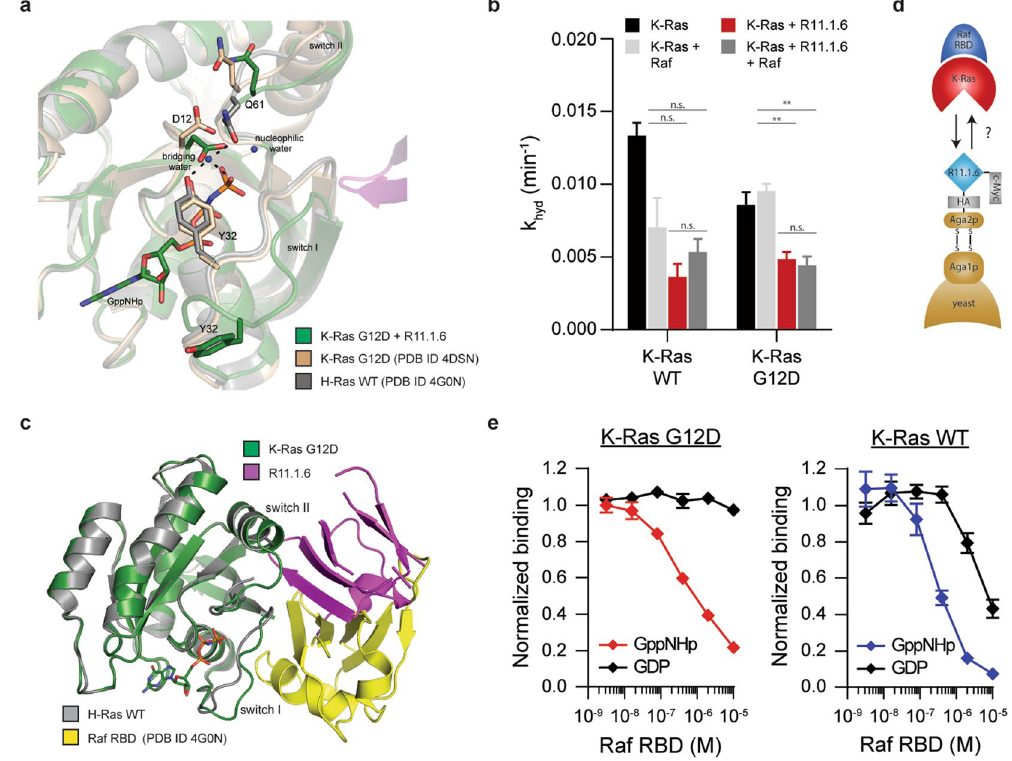
Figure 3. R11.1.6 reduces K-Ras intrinsic hydrolysis but directly competes with Raf. ( a ) Overlay of the co- crystal structure of R11.1.6 with K-Ras G12D with structures of K-Ras G12D in complex with a small molecule (PDB ID 4DSN) and H-Ras WT (PDB ID 4G0N), showing the disruption of Y32 and Q61 by R11.1.6, with an open switch I conformation. ( b ) Intrinsic hydrolysis rate constants (k hyd ) of K-Ras alone or in the presence of R11.1.6 and/or the Ras binding domains (RBD and CRD, residues 51–196) of Raf. Error bars represent SEM of n = 3 independent experiments. ** P < 0.01, 1-way ANOVA with Tukey post-test for analyzing all possible comparisons. ( c ) Overlay of the co-crystal structure of R11.1.6 with K-Ras G12D with the co-crystal structure of H-Ras WT with Raf RBD (PDB ID 4G0N). ( d ) Schematic representation of yeast surface display competition assay between R11.1.6 and Raf RBD for K-Ras binding. ( e ) Competition for binding of K-Ras as depicted in ( d ). Error bars represent SEM of n = 3 independent binding